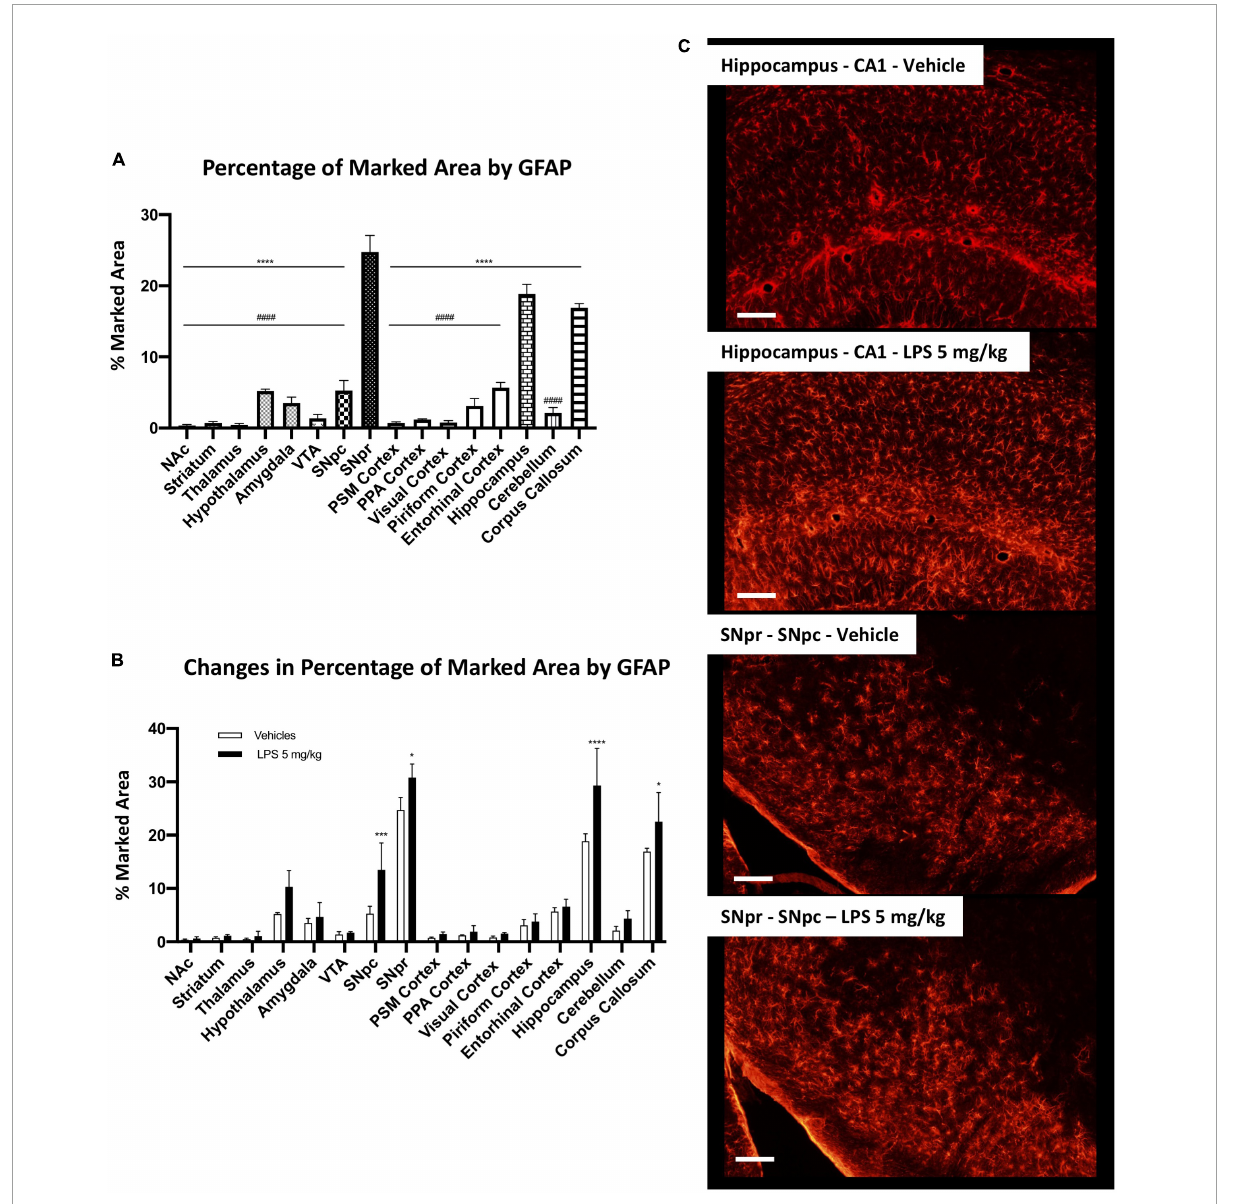
FIGURE8 Brain region-specific astrocyte distribution and activation induced by systemic LPS. (A) Percentage of the marked area by GFAP positive astrocytes in vehicles C57BL6N mice. One-way ANOVA F BrainRegions (15, 32) = 206.8, p < 0.0001, and n = 3 mice per region. Significance: (*) respect SNpr; (#) respect hippocampus and corpus callosum. Other significances are summarized in Supplementary Table 5 . (B) Percentage of the marked area by GFAP positive cells in vehicles (white columns) and LPS treated mice (black columns). Two-way ANOVA F BrainRegions (15, 64) = 100.6, p < 0.0001. F Treatment (1, 64) = 39.24, p < 0.0001. F Interaction (15, 64) = 3.406, p < 0.0003, and n = 3 mice per region. Significance: (*) respect relative vehicles. (C) Representative images of GFAP positive astrocytes in hippocampus and SNpr in vehicles and LPS treated